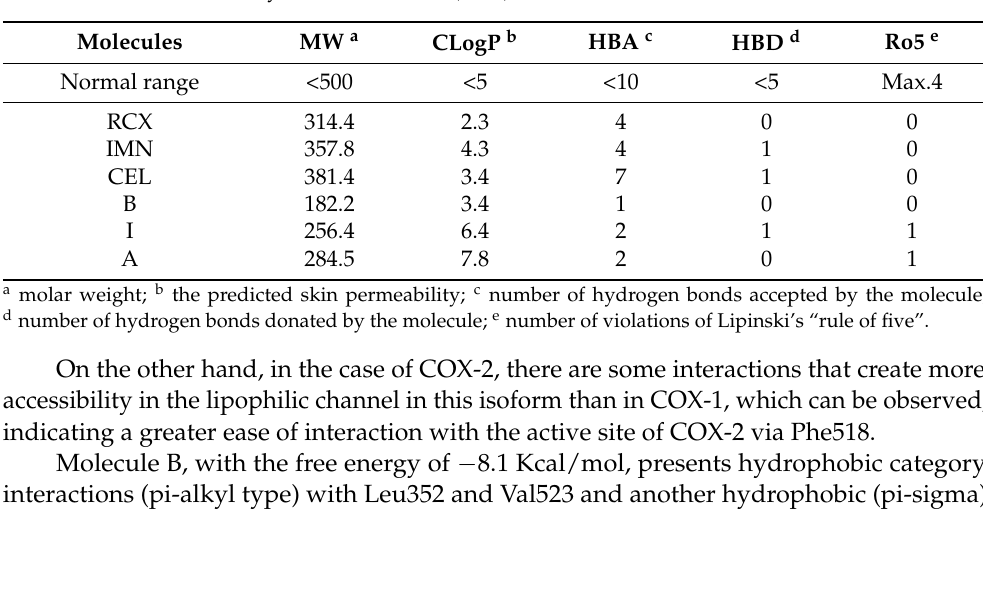
Table 3. Oral bioavailability of the molecules